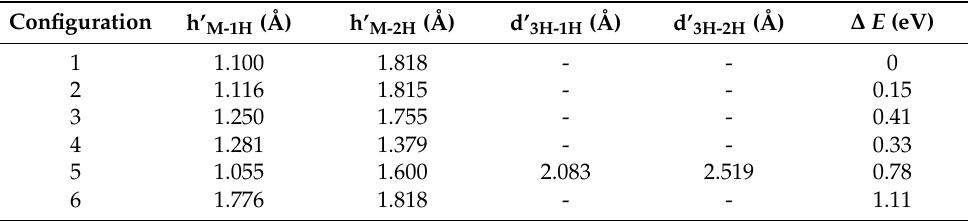
Table 1. and other configurations for atomic hydrogen desorption with an initial height of 3.0 Å. See Table 1 for a description of h’ M-1H , h’ M-2H , d’ 3H-1H and d’ 3H-2H . The geometrical structures for the considered six configurations are shown in Figure 2.